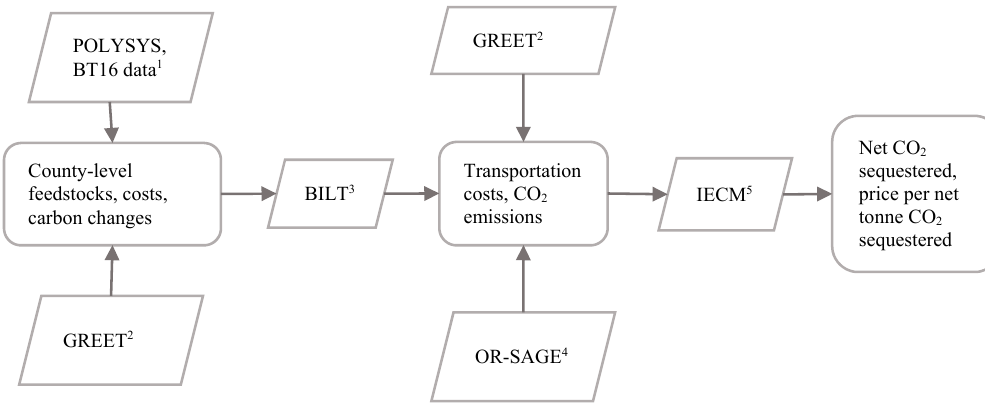
Figure 1. Generalized workflow diagram to quantify potential net tonnes of CO 2 sequestered, and $ per net tonne CO 2 sequestered with bioenergy with carbon capture and storage (BECCS). Key data inputs and model descriptions include: (1) feedstock outputs from the US Department of Energy (USDOE) (2016) [6], (2) CO 2 emissions outputs from Greenhouse gases, Regulated Emissions, and Energy use in Transportation (GREET ® ) model outputs from USDOE (2017) [48], (3) transportation costs and associated CO 2 emissions from the Biofuel Infrastructure, Logistics and Transportation Model (BILT), (4) biorefinery siting locations with the Oak Ridge Siting Analysis for power Generation Expansion (OR-SAGE), and (5) costs of electricity and CO 2 net sequestration from the Integrated Environmental Control Model (IECM).